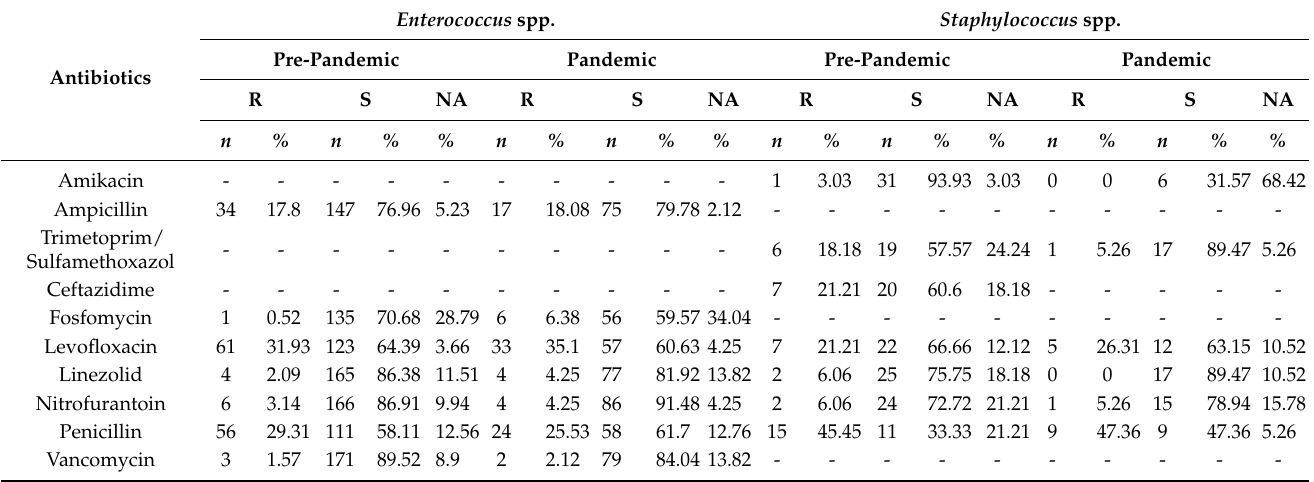
Table 5. Antibiotic resistance profile in Enterococcus spp. and Staphylococcus